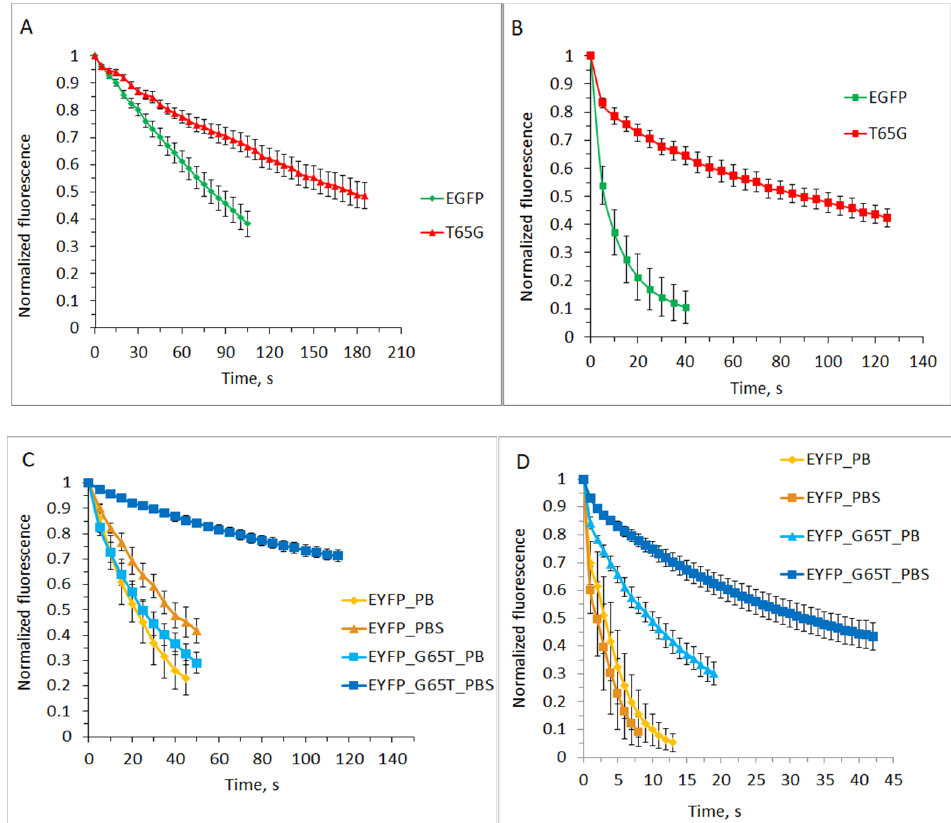
Figure 2. Bleaching kinetics in the immobilized proteins EGFP, EYFP, and their mutants in vitro . (A) Photoconversion of EGFP and EGFP-T65G in PBS. (B) Photoconversion of EGFP and EGFP-T65G in PBS in the presence of 0.2 mM potassium ferricyanide. (C) Photoconversion of EYFP and EYFP-G65T in PB and PBS (PBS contains potassium chloride). (D) Photoconversion of EYFP and EYFP-G65T in PB and PBS in the presence of 0.2 mM potassium ferricyanide. Green/yellow fluorescence intensities were background-subtracted and normalized to the maximum values. Standard deviation values ( n = 15 − 20 measurements in a representative experiment out of five independent experiments) are shown.